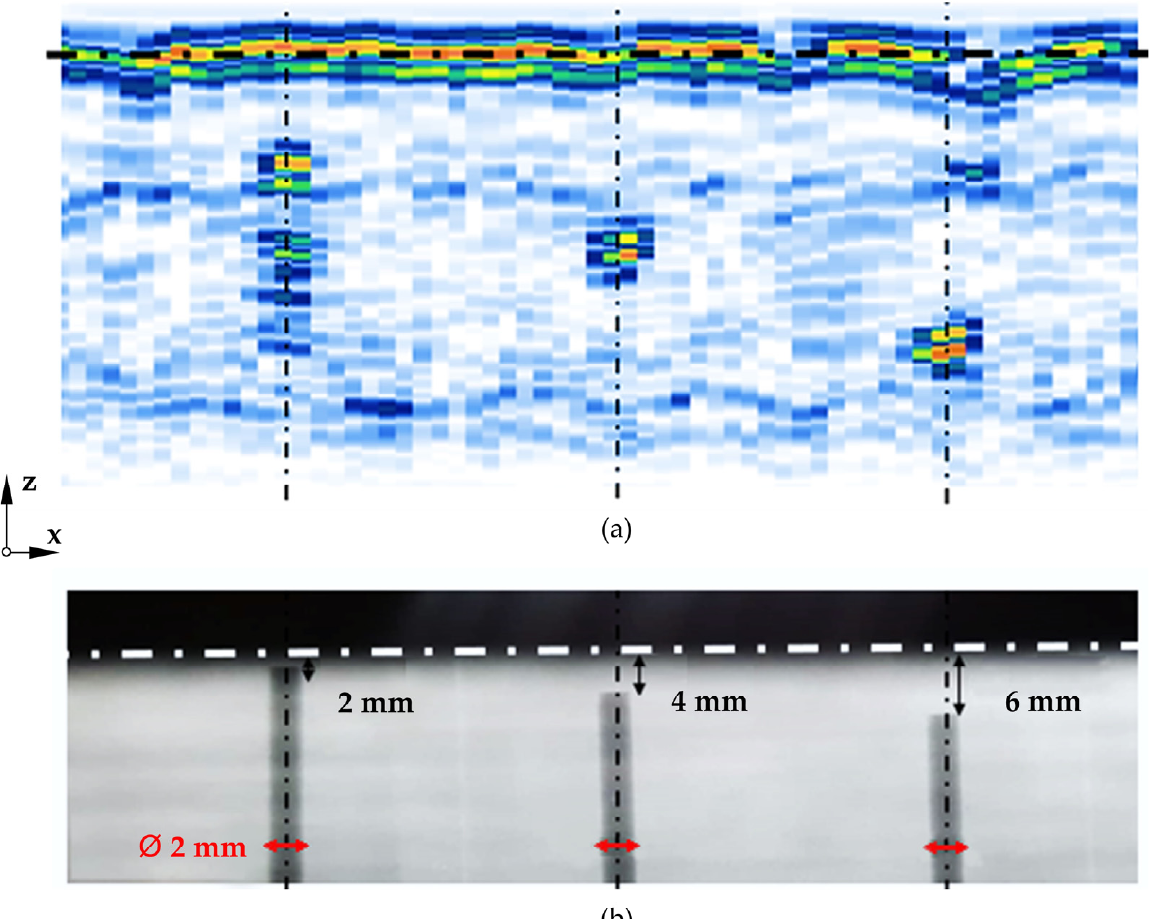
Figure 8. Detection of Ø 2 mm defects at varying depths on deposited ER5356 aluminum walls using ( a ) ultrasonic testing (UT) with the developed setup and ( b ) digital radiography (DR). The tests were carried out at room temperature.